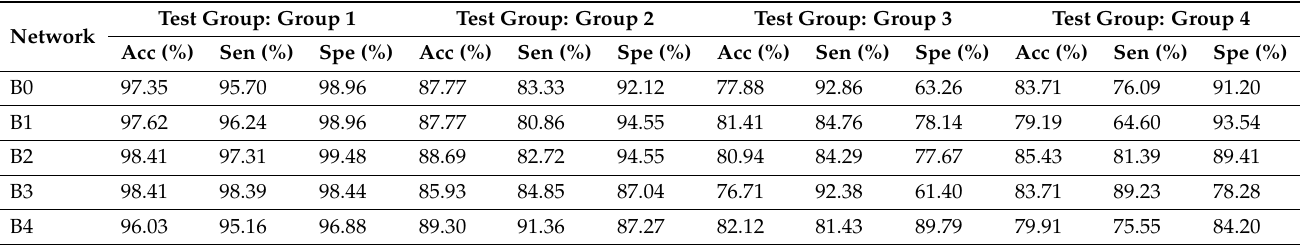
Table 12. The results of Experiment 6. Acc, Sen and Spe are the abbreviations for accuracy, sensitivity, and specificity,